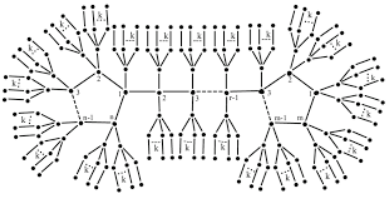
Figure 6. The graph Ω C k ( r , s , t )